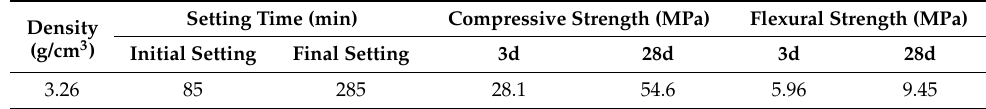
Table 1. Properties of cement.